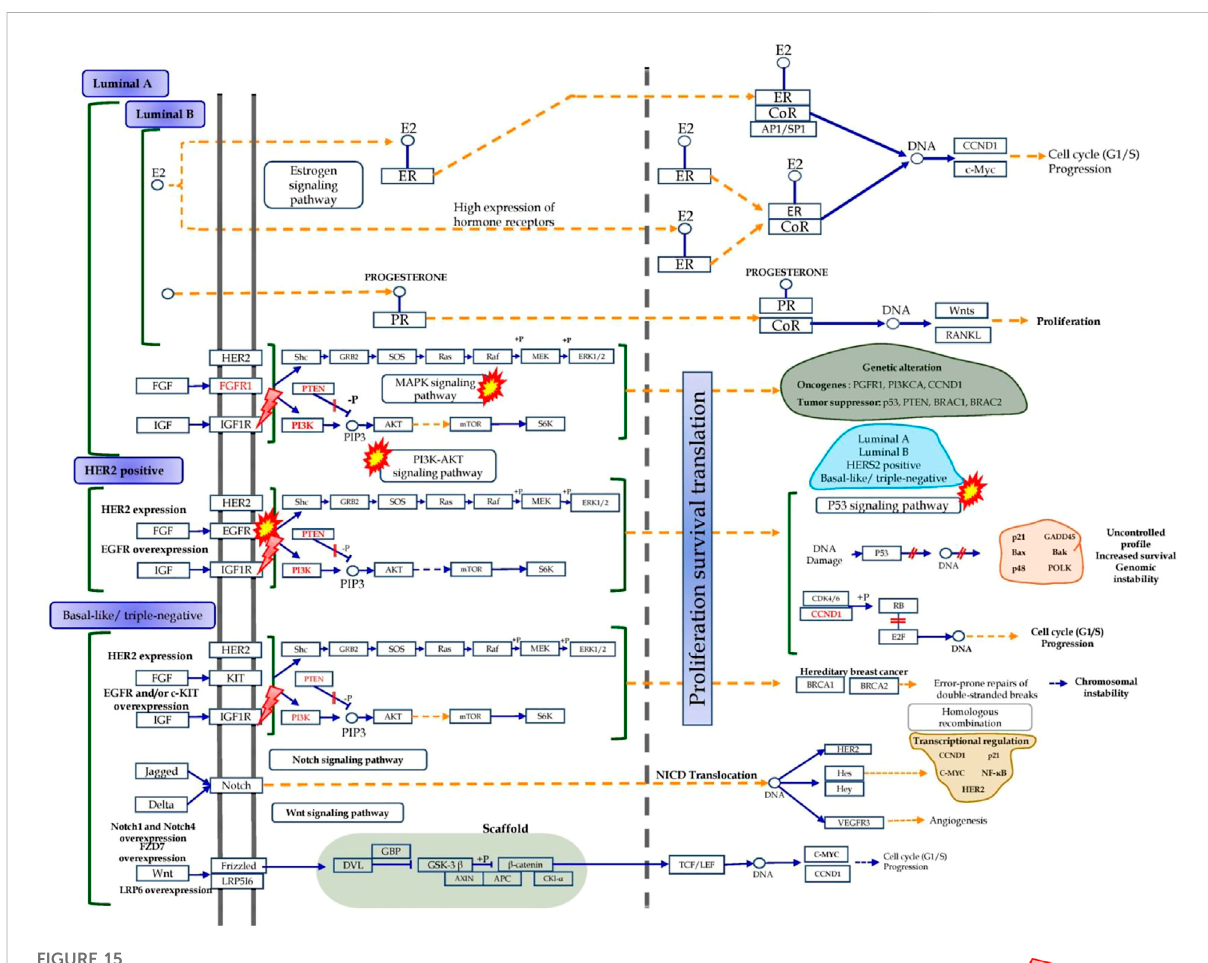
FIGURE 15 Probable checkpoints affected by the diosgenin in the pathogenesis of breast cancer ( Homo sapiens (human); hsa05224 ) targets/